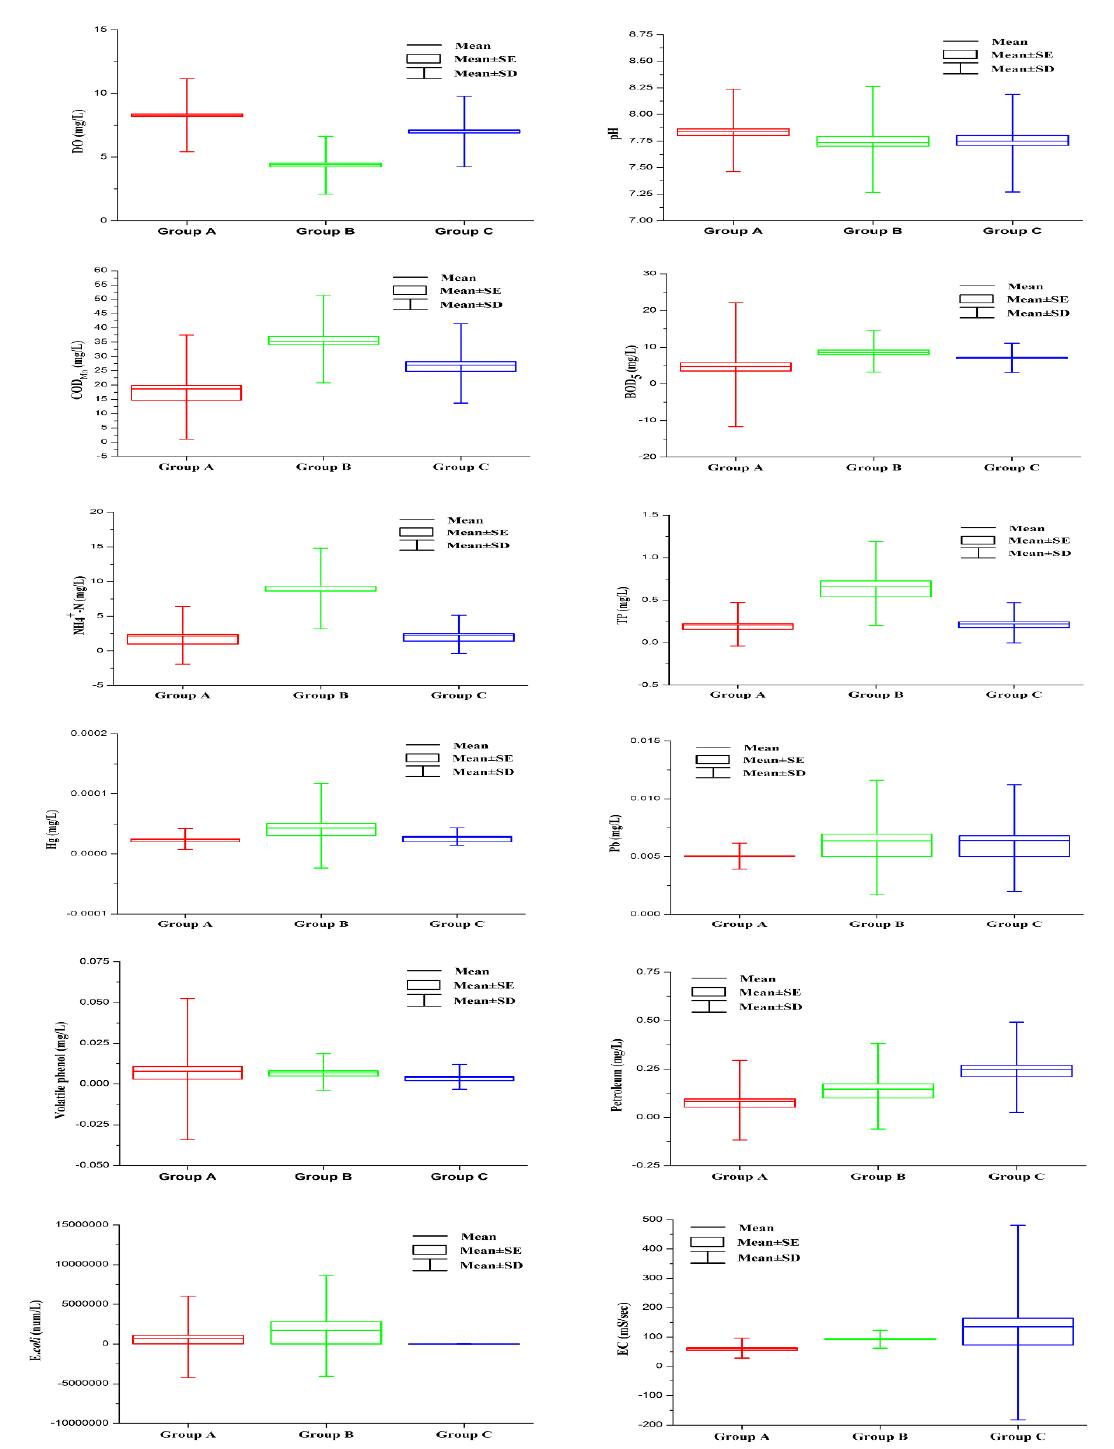
Figure 5. Box and whisker plots of discriminant parameters (not including temperature) produced through spatial discriminant analysis.